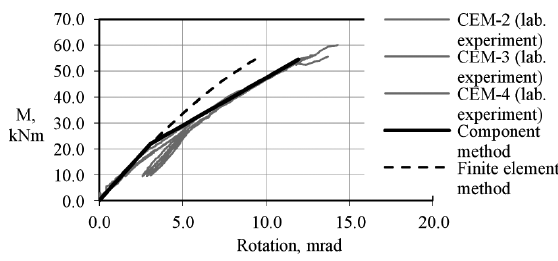
Fig. 10. Component method based moment-rotation curves for joints with different end-plate